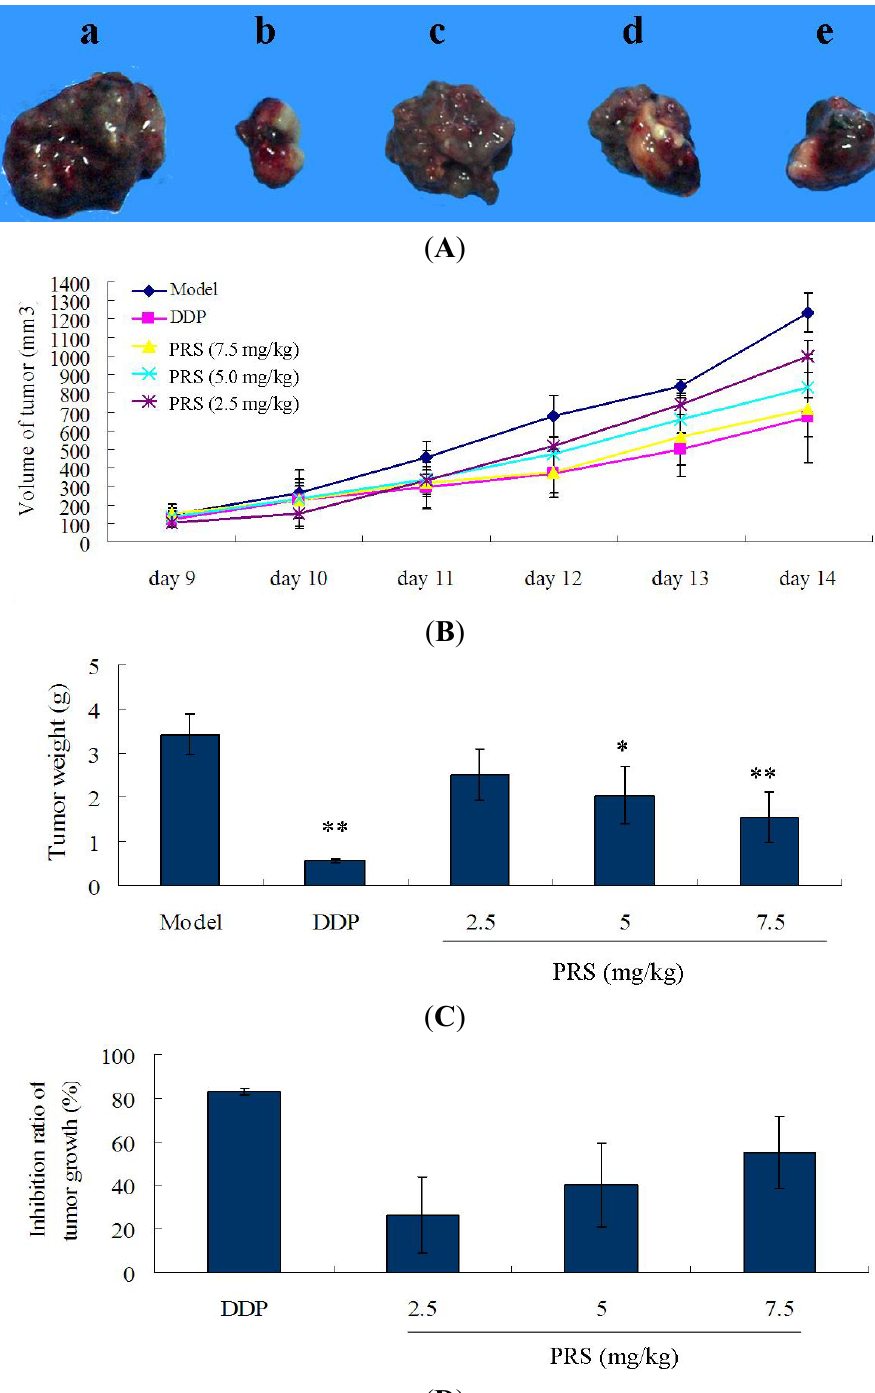
Figure 3. Effect of PPSC on tumor volu me ( A and B ), tumor weight ( C ) and tumor growth ( D ) in lewis-bearing C57BL/6 mice. These mice were injected with 0.2 mL Lewis cells (10 7 cells/mL) and administered orally by PRS (2.5, 5.0 and 7.5 mg/kg) from 2nd day to 14th day. This experiment was repeated for three times and at least 5–6 mice for each. ( n = 15 − 18). Data are expressed as means ± SD. * p < 0.05, ** p < 0.01, PRS or DDP vs .